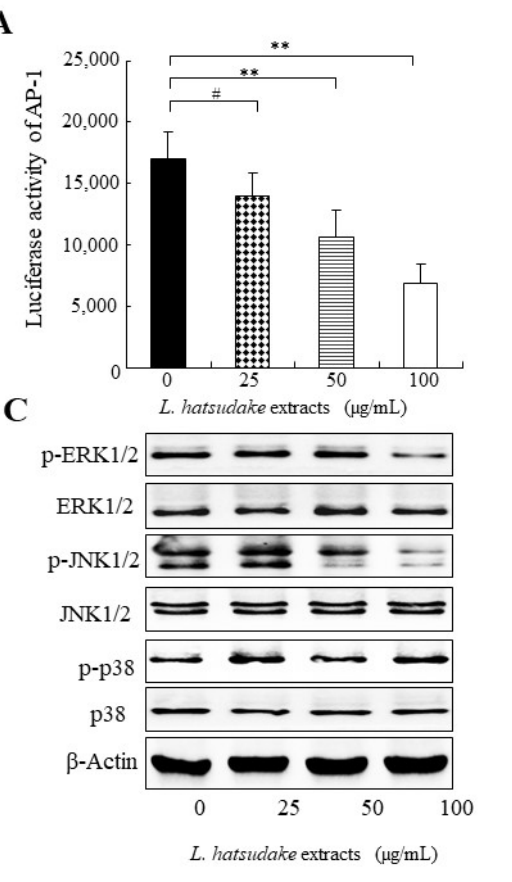
Figure 5. The effect of L. hatsudake extracts on the activities of AP-1, NFκB and MAPK signal path- way in HCT116 cancer cells. ( A ) L. hatsudake extracts inhibited the transcript activity of AP-1 in HCT116 cancer cells. ( B ) L. hatsudake extracts inhibited the transcript activity of NFκB in HCT116 cancer cells. **: p < 0.01; #: p > 0.05. ( C ) The effect of L. hatsudake extracts on MAPK signal pathway in HCT116 cancer cells.